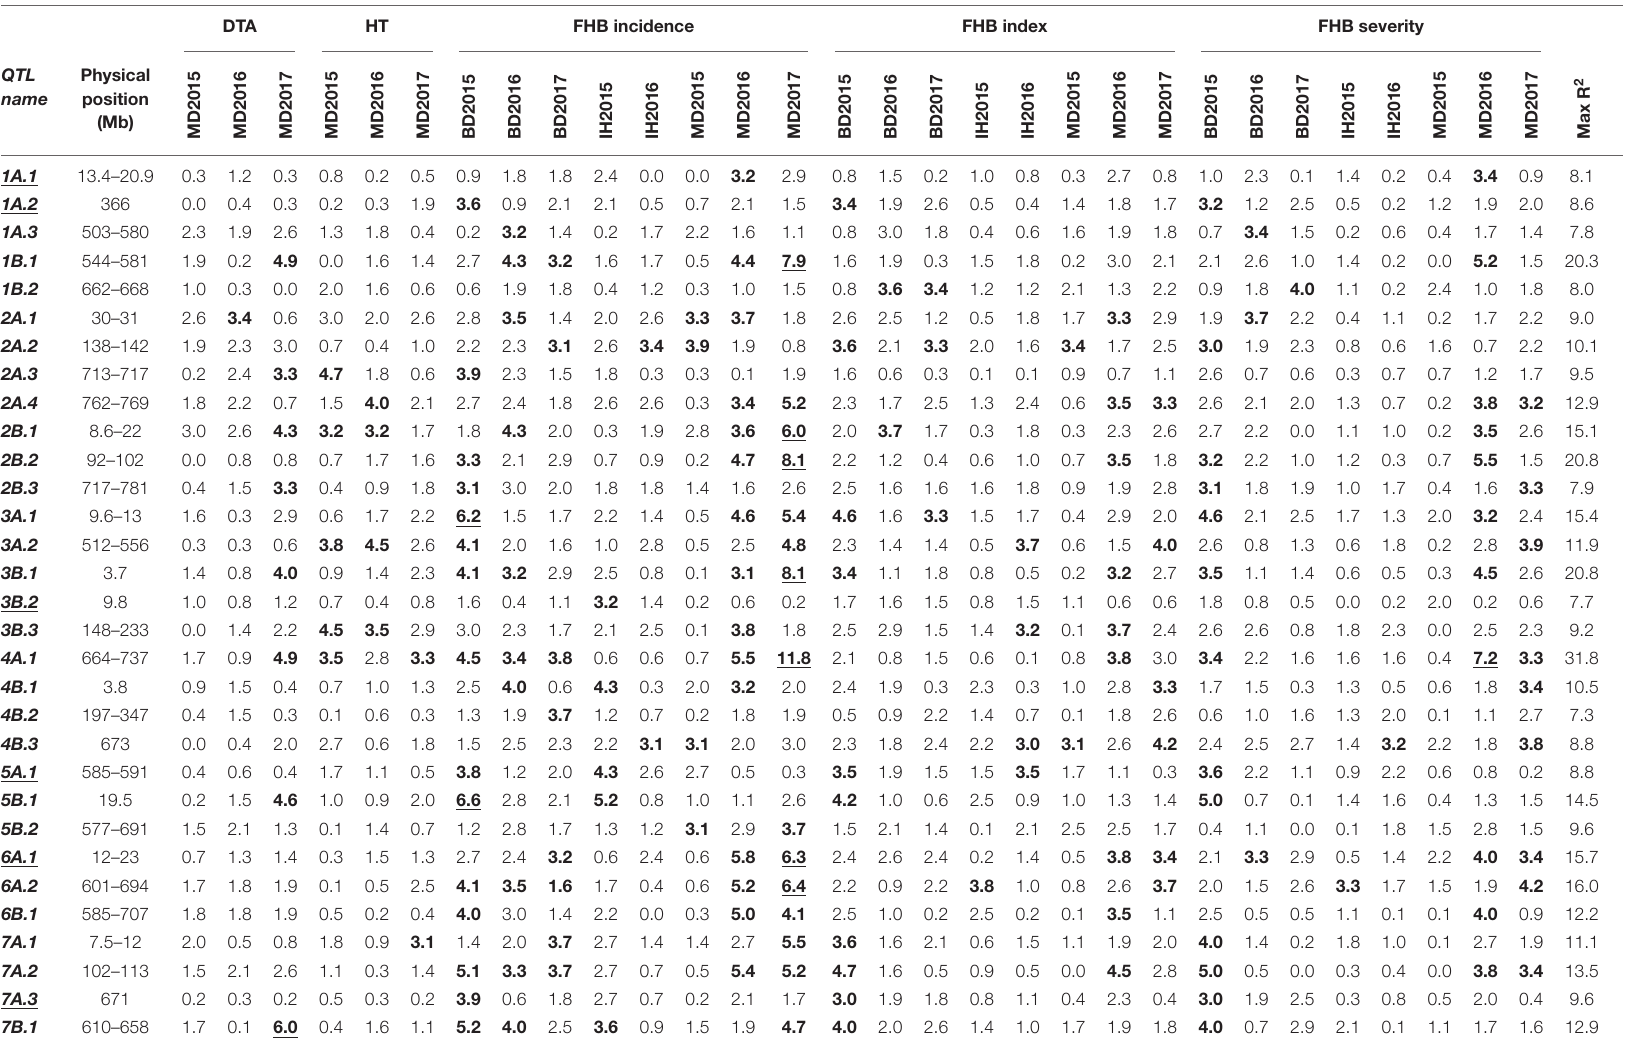
TABLE 2 | Quantitative trait loci names, physical positions, associated traits, explained phenotypic variance and significance of association with Fusarium head blight incidence (INC), index (IND), severity (SEV), days to anthesis (DTA), and plant height (HT) identified from durum association mapping panel across environments. DTA HT FHB incidence FHB